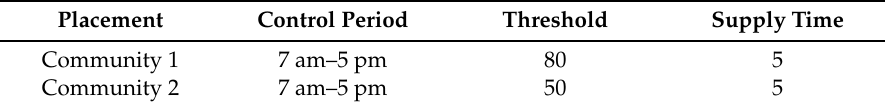
Table 3. Control settings of each tomato